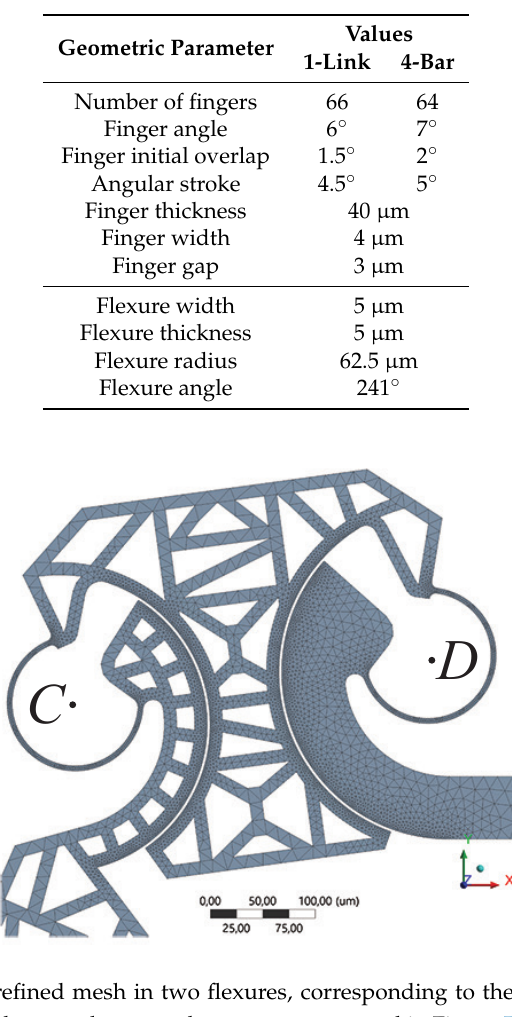
Table 1. Geometric parameters of comb-drive and flexures.